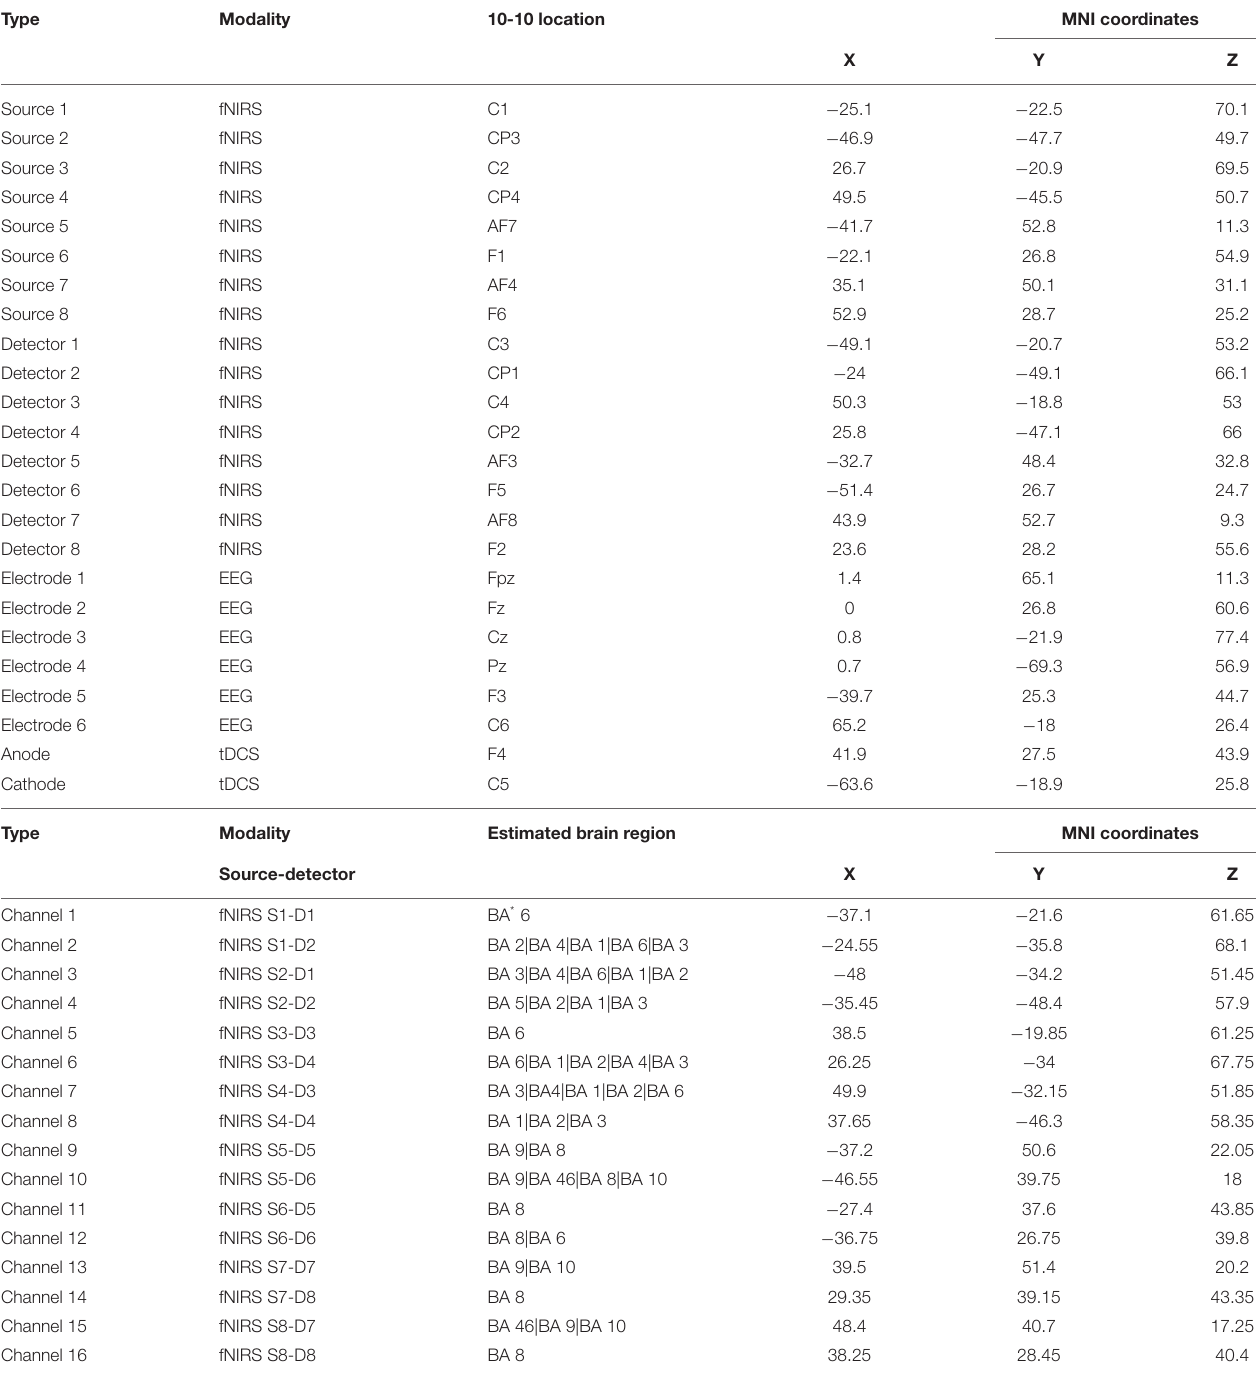
TABLE 2 | The neuroimaging localization results for fNIRS optodes, channels, EEG, and tDCS